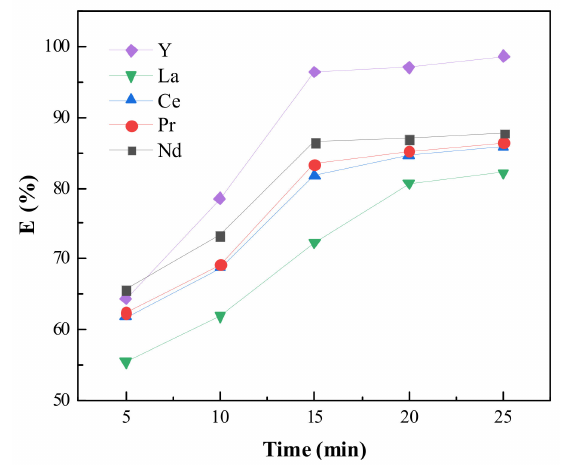
Figure 5. Effect of extraction time on the extraction of